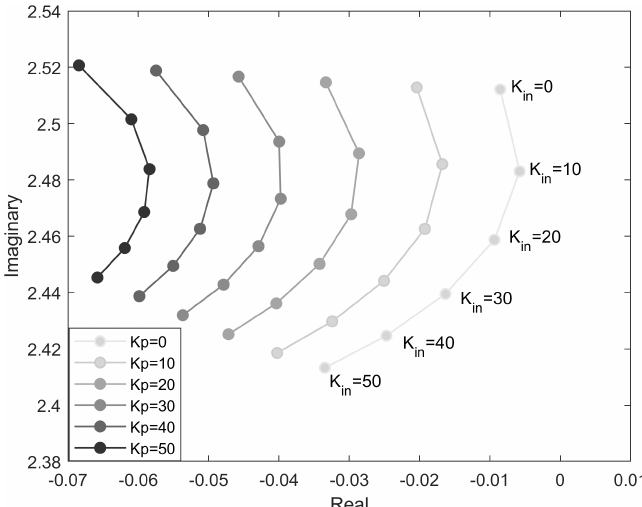
Figure 16. Sensitivity analysis of inter-area modes to K p and K in